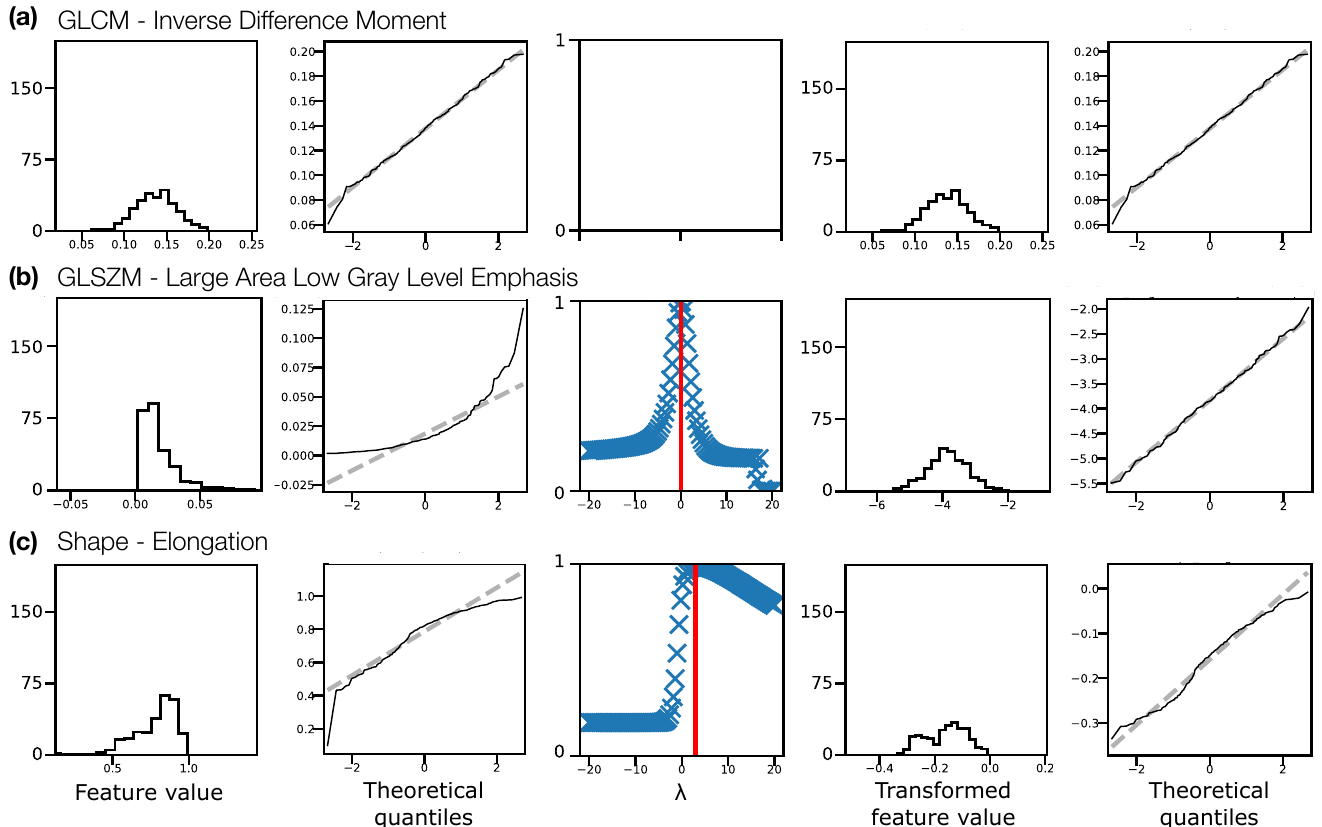
Figure 2. Feature distributions and transformations for three example features, ( a ) Inverse Difference Moment, ( b ) Large Area Low Gray Level Emphasis, ( c ) Elongation, from non-normalised T 1 W pre-contrast images, pooling feature values from both visits for all subjects. Feature distributions and Q-Q plots for the original features are shown in the first and second columns, respectively. The third column shows the Box–Cox normality plots, with red vertical lines indicating the optimal λ to use to transform the distributions. Feature distributions and Q-Q plots for the transformed features are shown in the fourth and fifth columns, respectively. In ( a ) the original distribution is consistent with a Gaussian distribution (Shapiro–Wilk test), and does not require a transformation. In ( b ) the original distribution is not consistent with a Gaussian distribution, and the transformation corrects this. In ( c ) the original distribution is not consistent with a Gaussian distribution, but the transformed distribution is still not Gaussian, though the Q-Q plots suggest the transformed distribution is closer to Gaussian than the original. Y-axis labels are omitted for clarity, but are: Counts, Sample quantiles, Correlation coefficient, Counts, Sample quantiles, for each column,